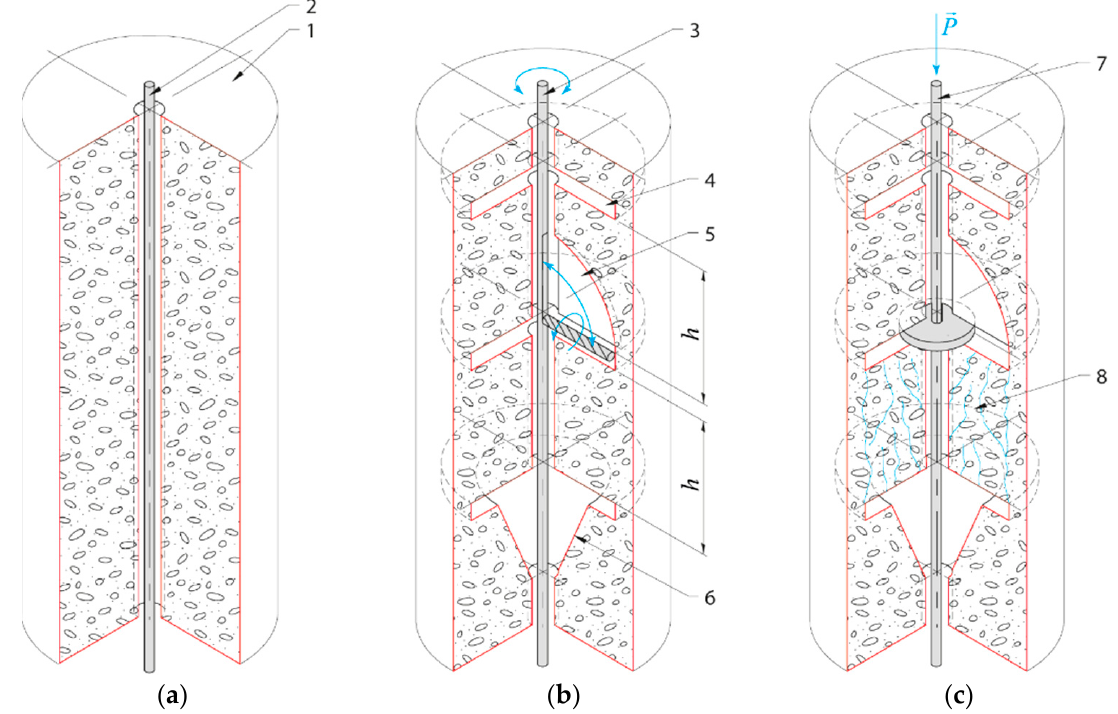
Figure 1. Stages of productive stratum expanded drainage zone formation: 1—rock, 2—drill string, 3—special bottomhole assembly for radial hole drilling in the well, 4—circular recess, 5—recess formed by drilling of the radial hole, 6—conical hole, 7—special bottomhole assembly for cantilever rock destruction and grinding, 8—zone of rock destruction by static and dynamic axial force.